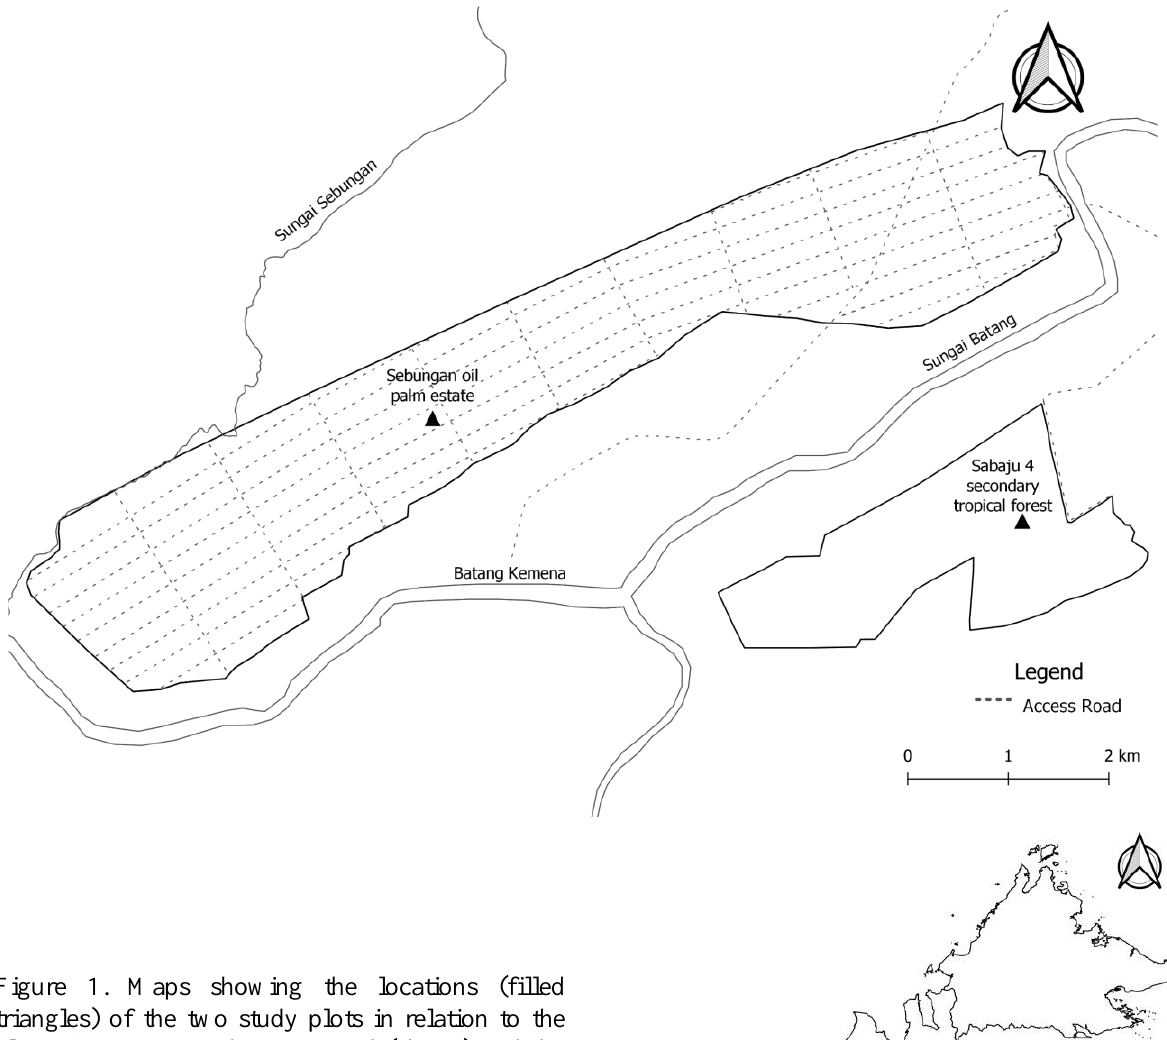
Figure 1. Maps showing the locations (filled triangles) of the two study plots in relation to the plantation, rivers and access road (above) and the study area within Sarawak